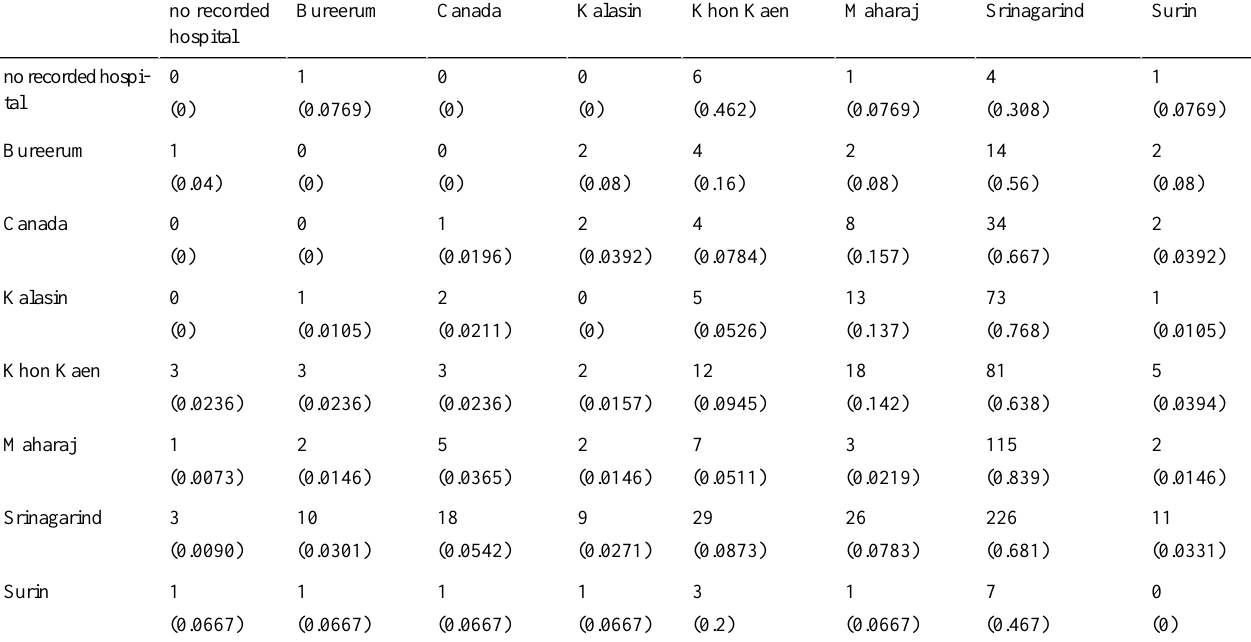
Table 6. The interhospital communications.